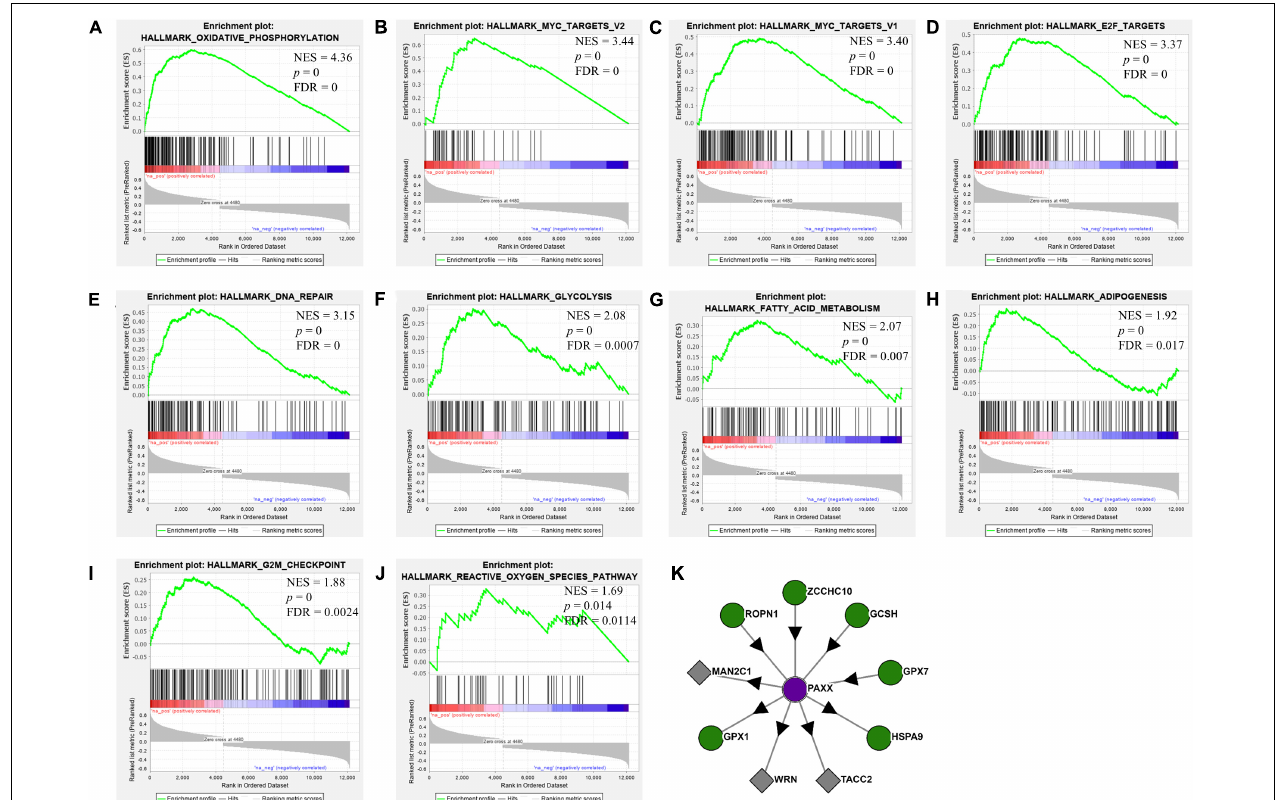
FIGURE 8 | Gene set enrichment analysis of PAXX correlated genes in the TCGA-COAD dataset. Each plot (A–J) depicts positively enriched pathways of PAXX correlated genes with normalized enrichment score (NES), false discovery rate (FDR), and p -value depicted inside the respective pathway. (K) Depict results from the Bioplex 2.0 web server, showing protein-protein interactions of PAXX in HCT-116 colon cancer cell line.